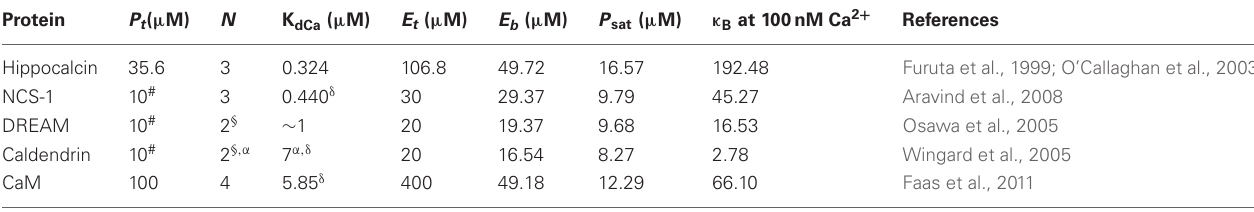
Table 1A | Concentration, affinity, and other parameters of selected neuronal Ca 2 + sensors and CaM.